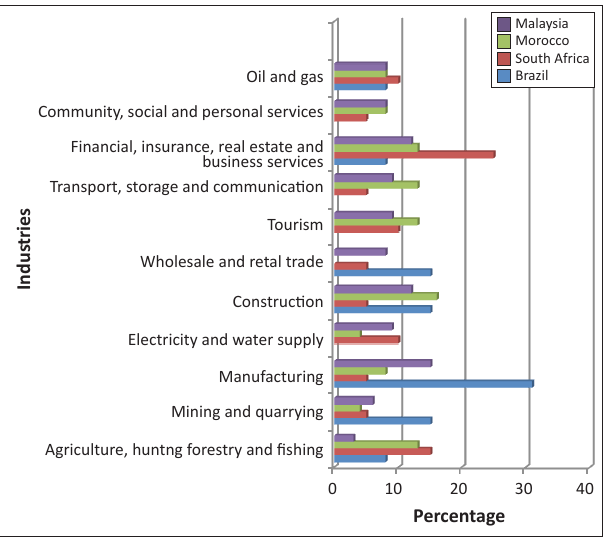
FIGURE 1: Industries represented by the respondents in this